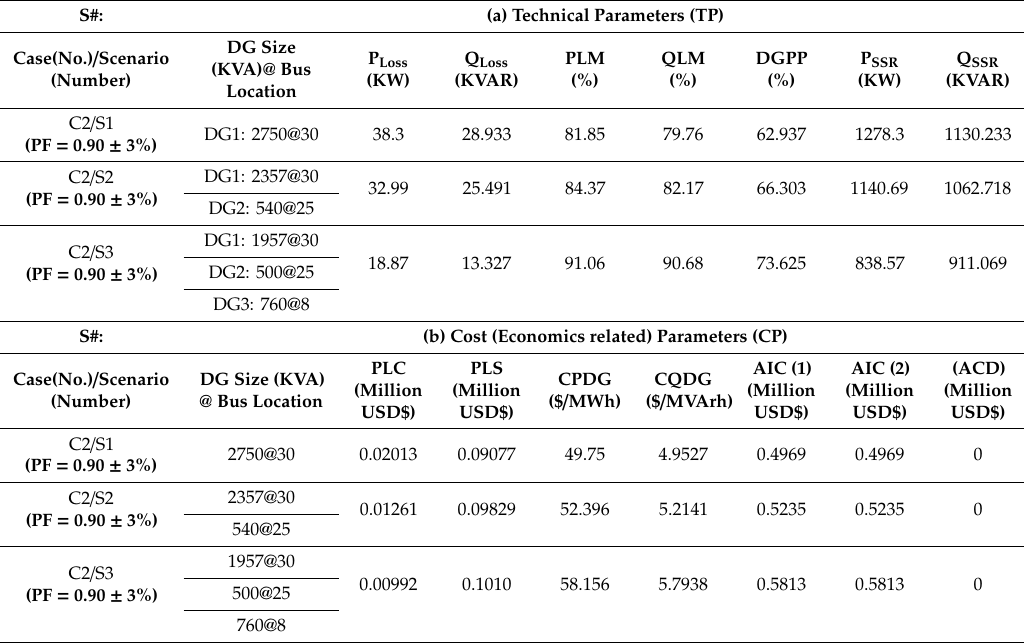
Table 6. (a) Overview of technical performance evaluation analysis in case 2 for 33-bus TDS. 6 ( b ). Overview of Cost-Economics performance evaluation analysis in case 2 for 33-bus